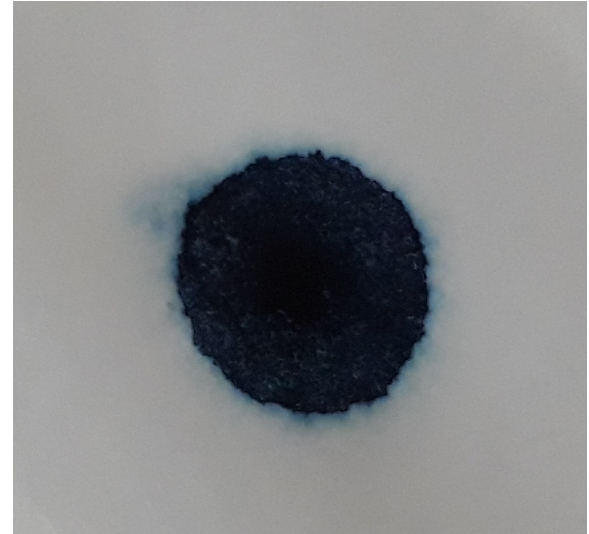
Figure 6. Slightly pronounced light blue ring.